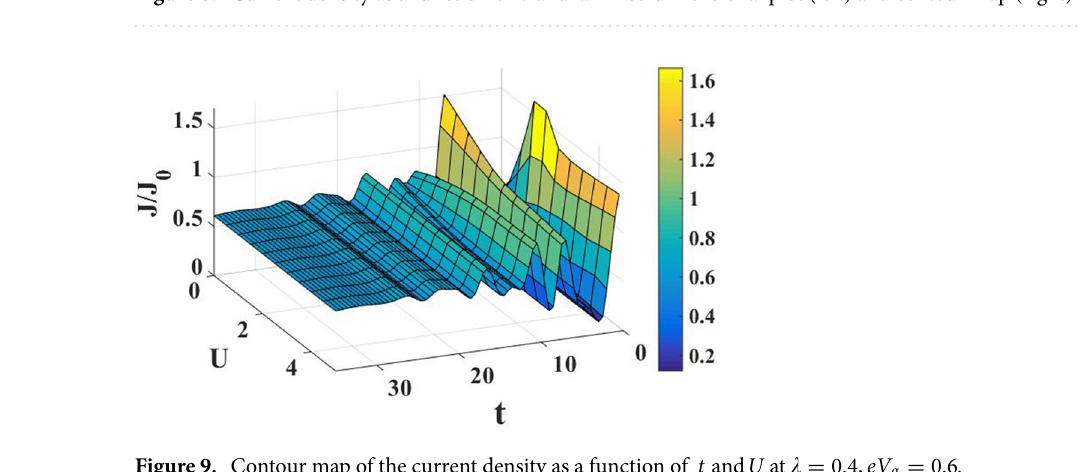
Figure 8. Current density as a function of t and (cid:31) . Three-dimensional plot (left) and contour map (right) .